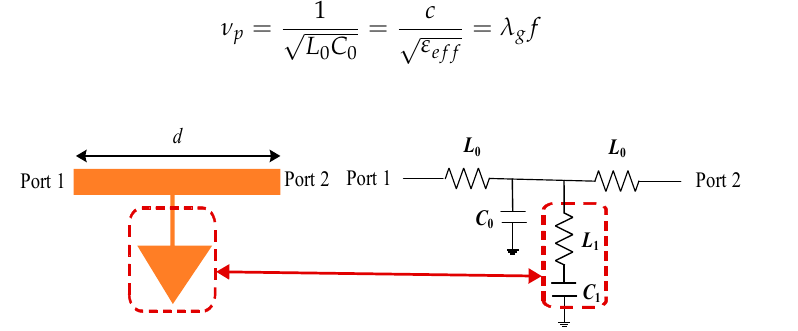
Figure 7. Transmission line model with LC loadings.